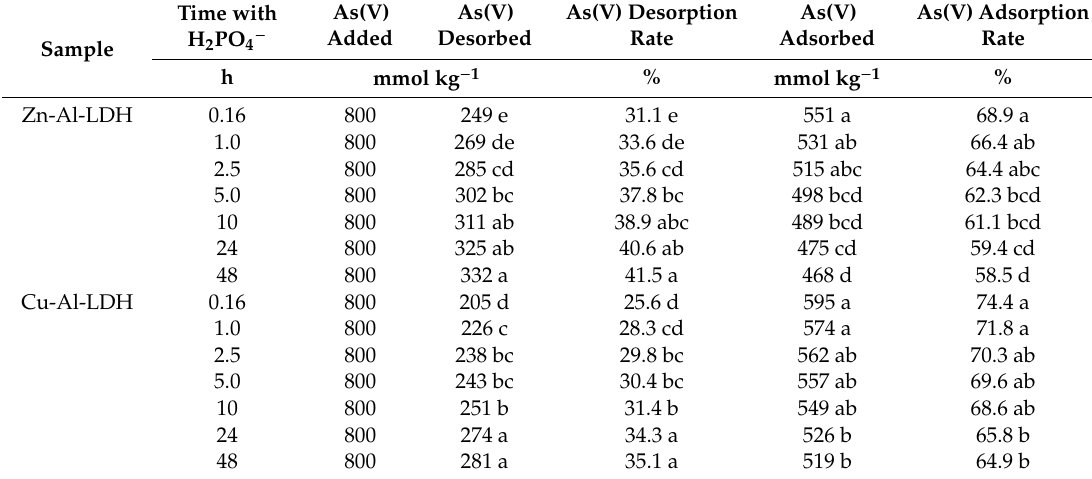
Table 5. Kinetics of desorption of As(V) by H 2 PO 4 − on Zn-Al-LDH and Cu-Al-LDH, at pH = 7.